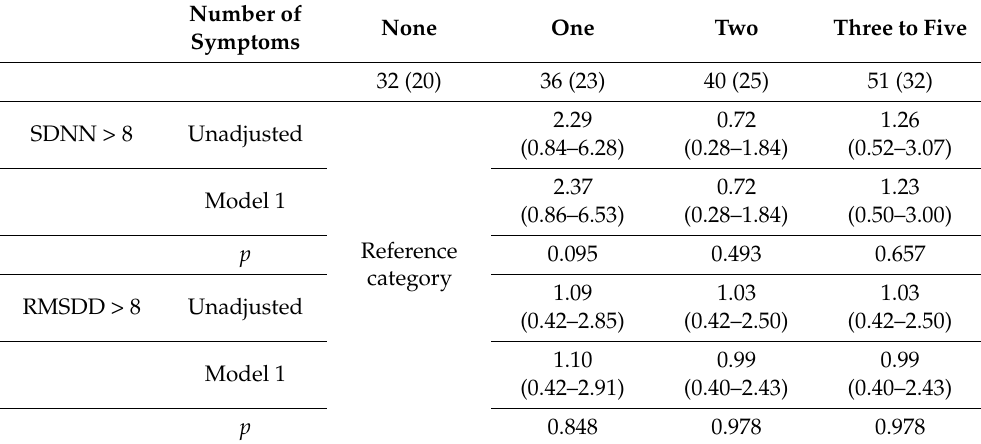
Model 1: Adjusted for age groups and gender. Note: SDNN = standard deviation of normal to normal heartbeat intervals; RMSDD = root mean square of successive differences between adjacent heartbeats. Both SDNN and RMSSD cut-offs are in